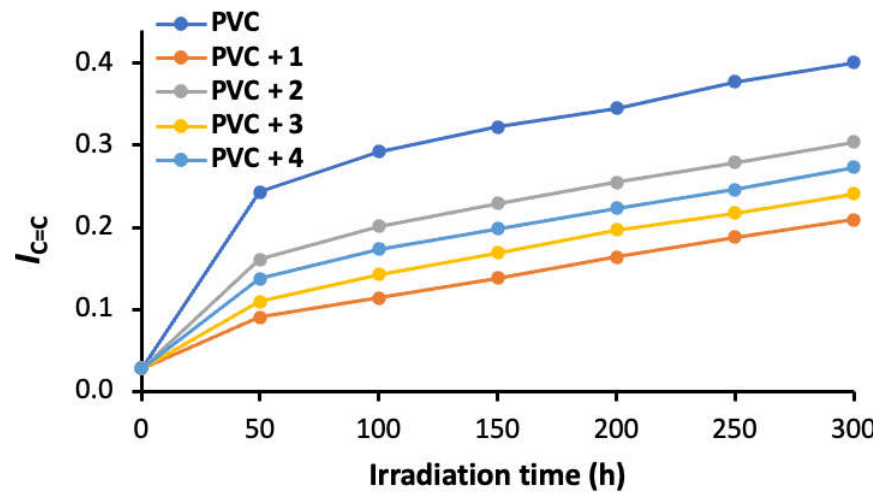
Figure 4. A plot showing the evolution of the I C=C for PVC films as a function of irradiation time.